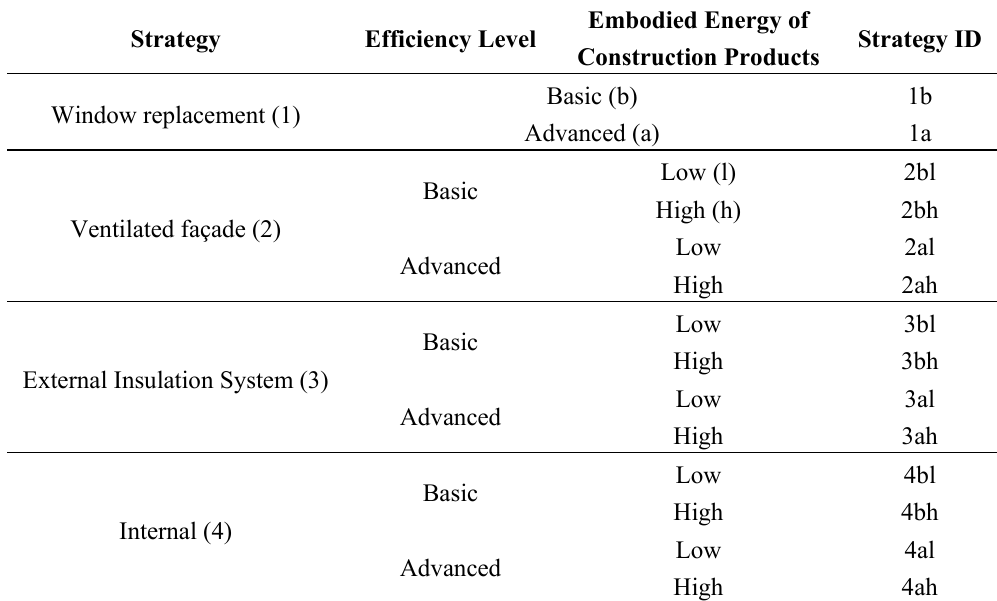
Table 4. Set of energy refurbishment strategies applied in the case